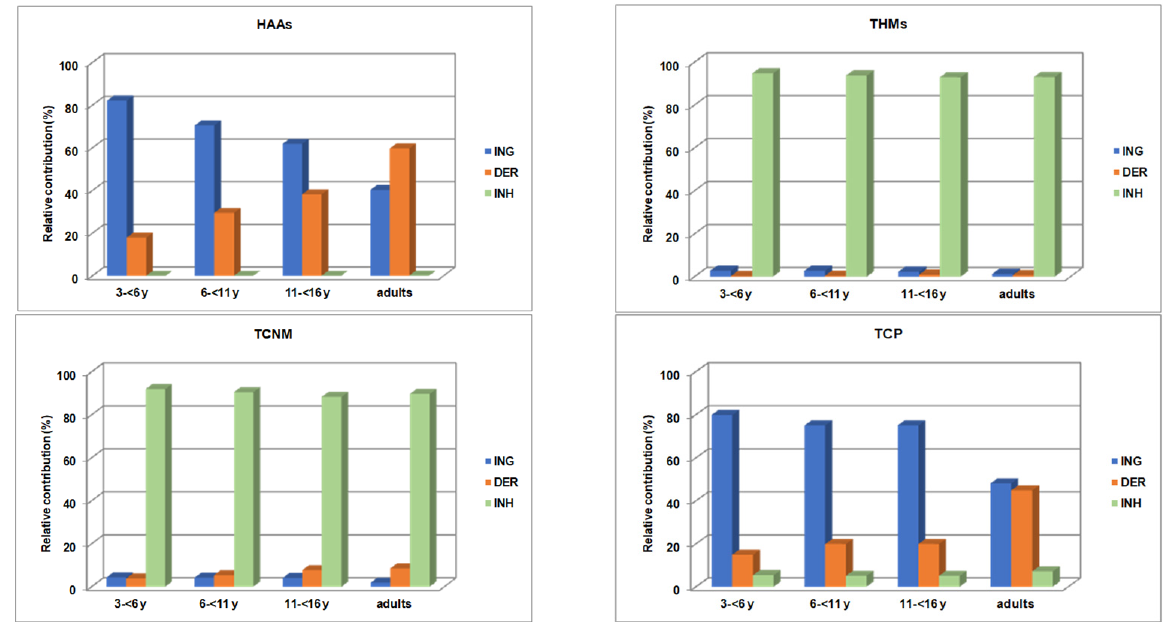
Figure 3. Relative contribution of exposure routes to DBPs (ING: ingestion, DER: dermal and INH: inhalation).